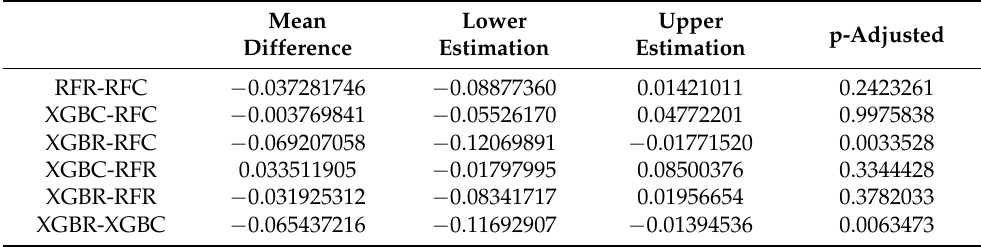
Table 2. Tukey’s multiple comparisons of classifiers’ and regressors’ f1 mean